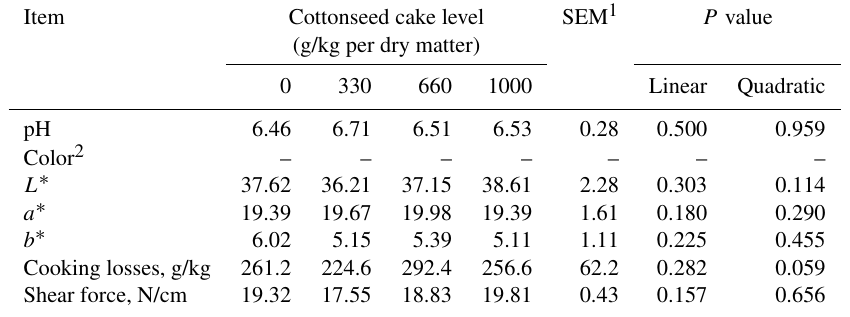
Table 5. Qualitative traits of the longissimus lumborum muscle of feedlot goats fed diets containing cottonseed cake replacing soybean meal.